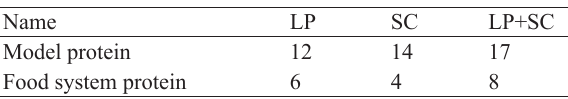
Table 2 Proteolytic activity of Lactobacillus plantarum and Staphylococcus carnosus in relation to proteins of animal- based food systems,